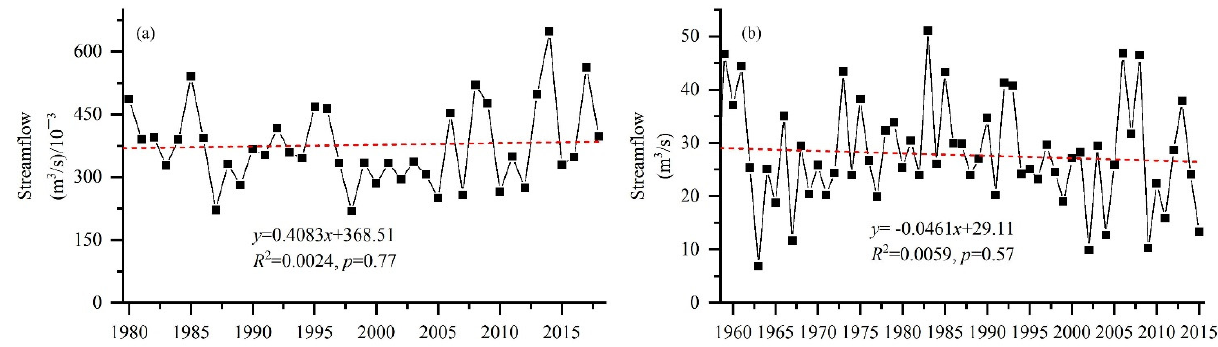
Figure 8. The change trend of annual streamflow in at the HP0 site of Harp Lake ( a ) and the Lantang station of the Dongjiang River ( b ) catchment.